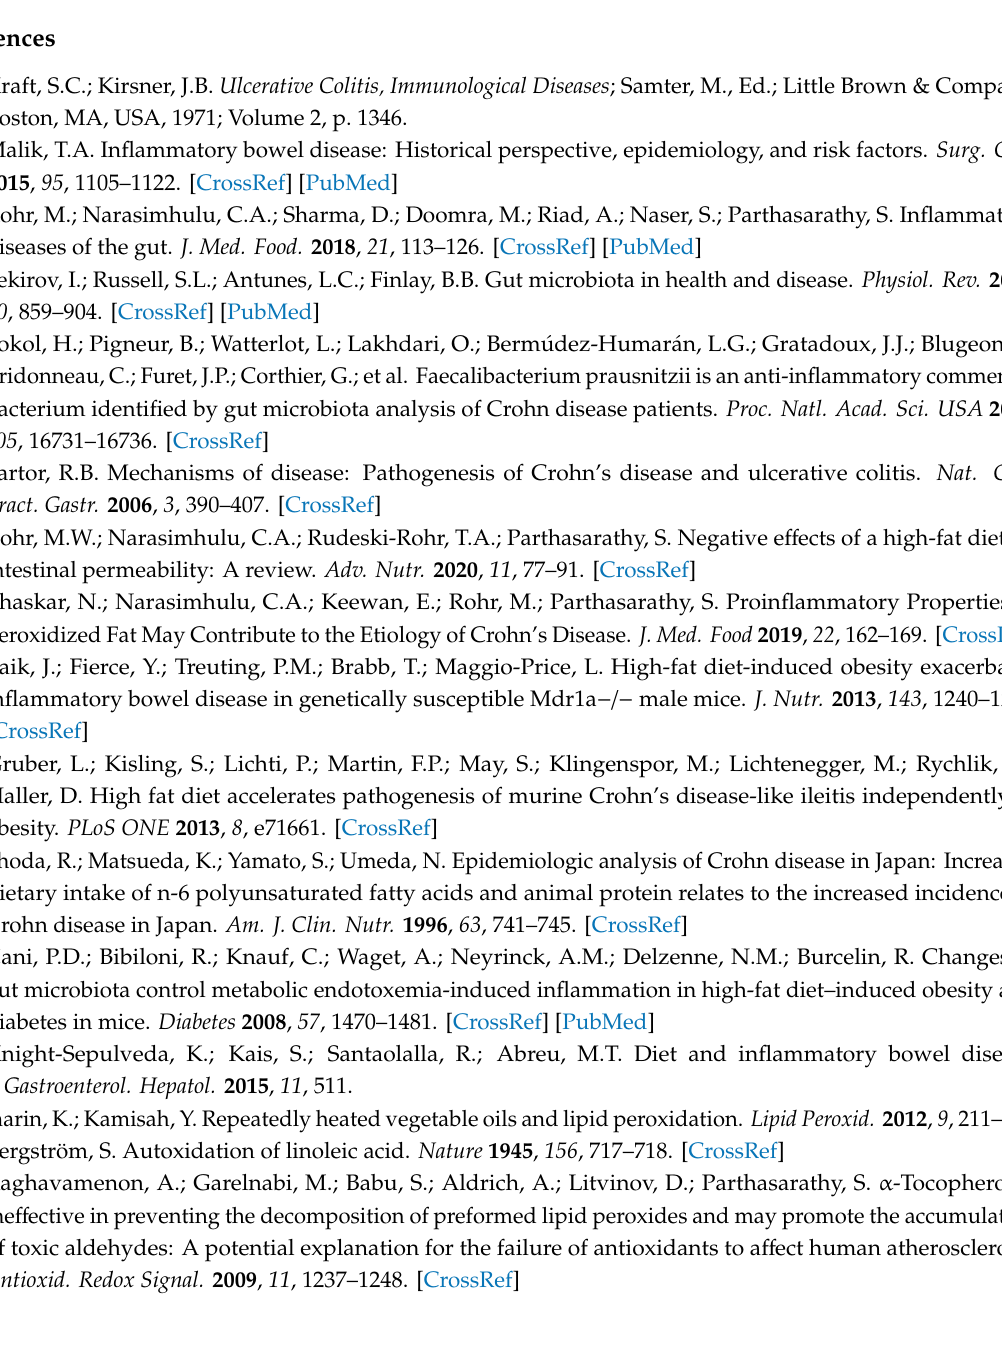
Table S1: List of oligonucleotides used for the study; Figure S1: 13-HPODE itself and associated Caco-2 inflammation induces THP-1